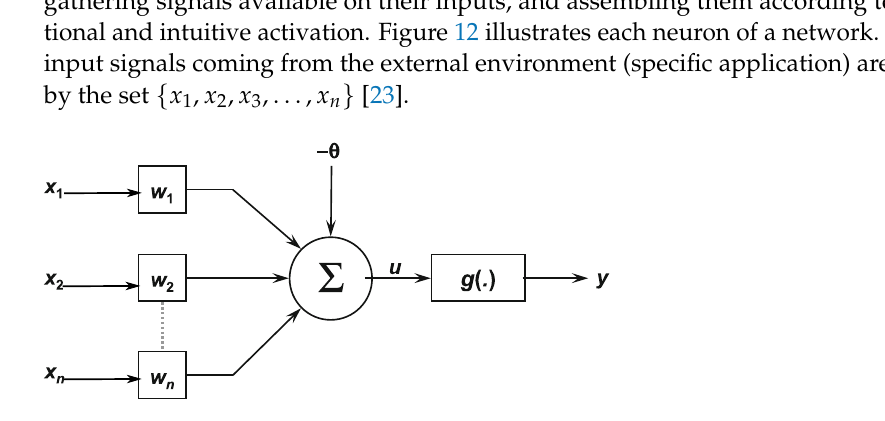
Figure 12. Artificial neural